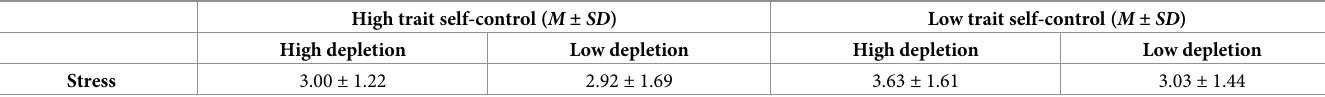
Table 4. Descriptive statistics of the degree of stress.